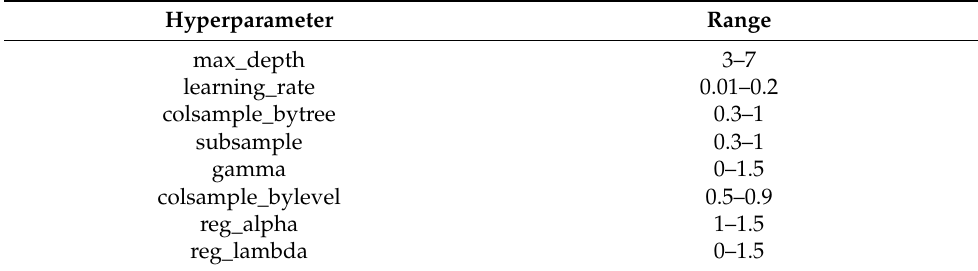
Table 1. The hyperparameters of the XGBoost